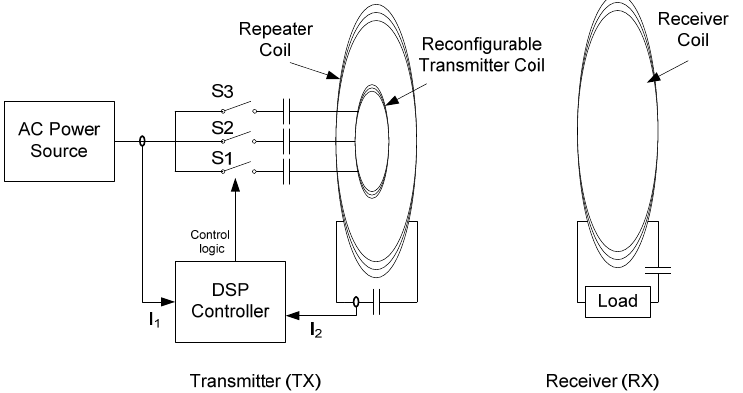
Figure 3. Simplified schematic diagram of the proposed reconfigurable three-coil IPT